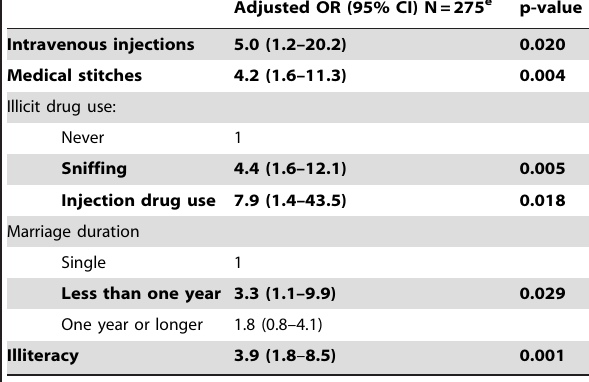
Table 4. Multivariate analysis showing factors independently associated with acute hepatitis C, Greater Cairo,